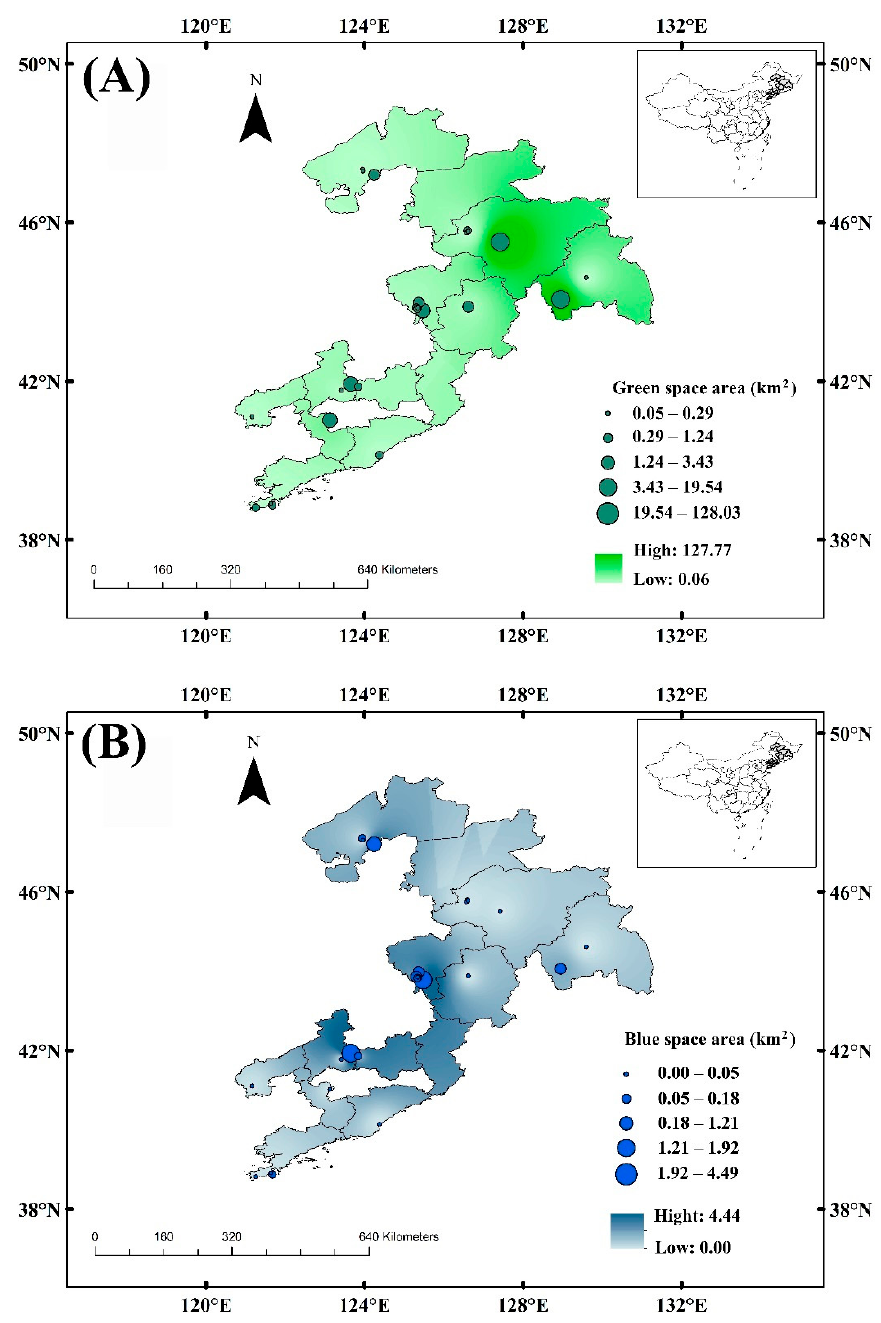
Figure 4. Spatial distributions of green land areas ( A ) and aquatic areas ( B ) of urban forest parks in Northeast China. Gradient spreads of green land area and aquatic area are both mapped using data predicted by spatial interpolations.